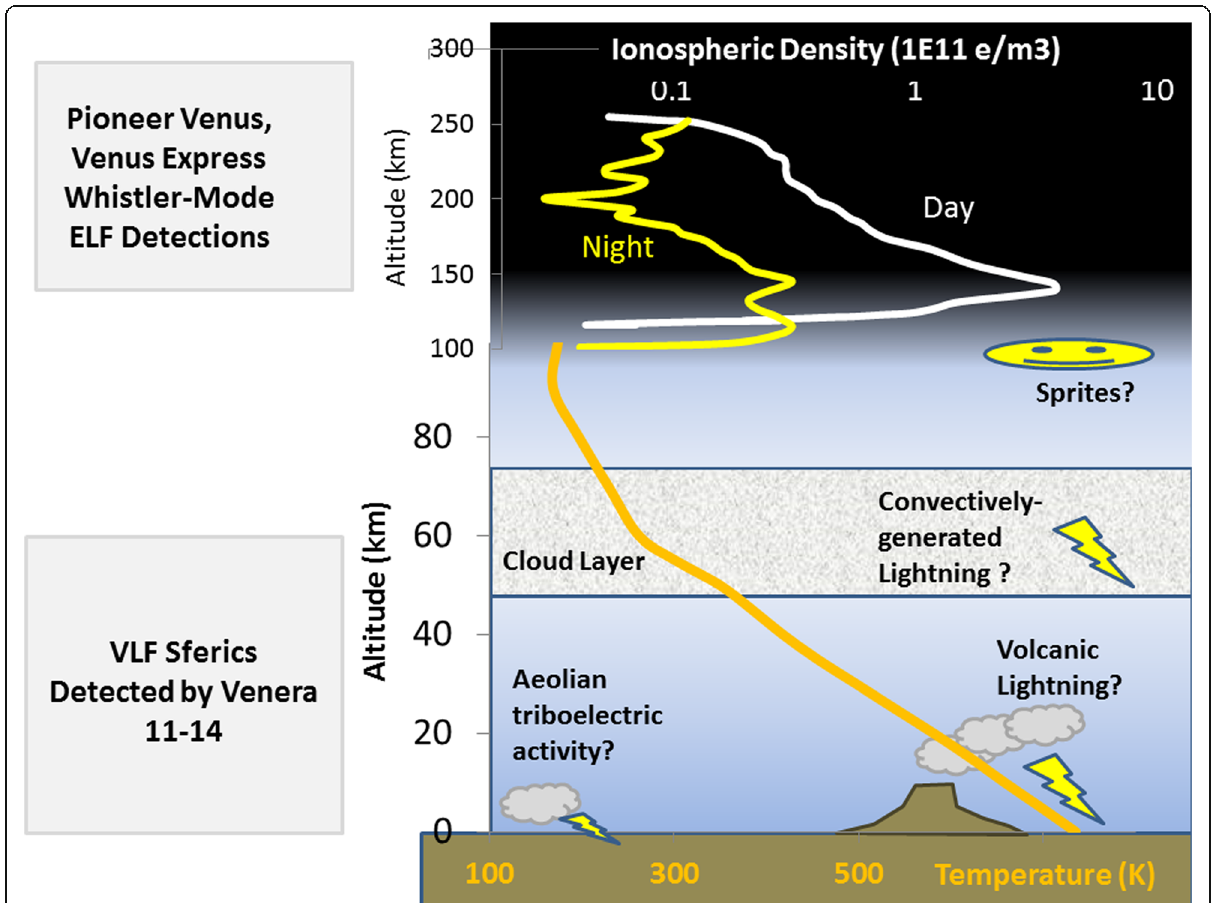
Fig. 2 Structure of the Venus atmosphere showing the ionosphere peaking between 100 and 150 km altitude (with daytime densities exceeding 10 5 cm − 3 ) and the temperature profile with the main cloud layer around 60 km altitude. Possible sites of electro-optical activity are noted — eolian and volcanic discharges near the surface, convective lightning in the cloud layer, and possible transient luminous events like sprites in the mesosphere. The corresponding altitudes of positive indications of lightning are noted at